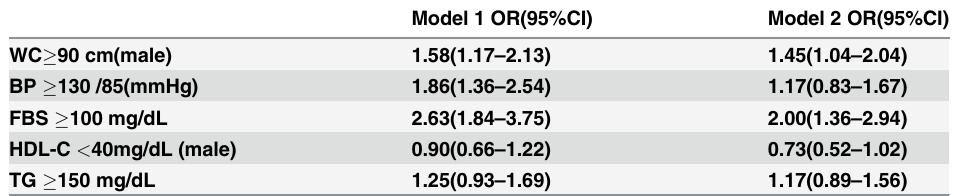
Table 3. Relationship between Metabolic Syndrome Components and Coronary Artery Calcification. Model 1 OR(95%CI)